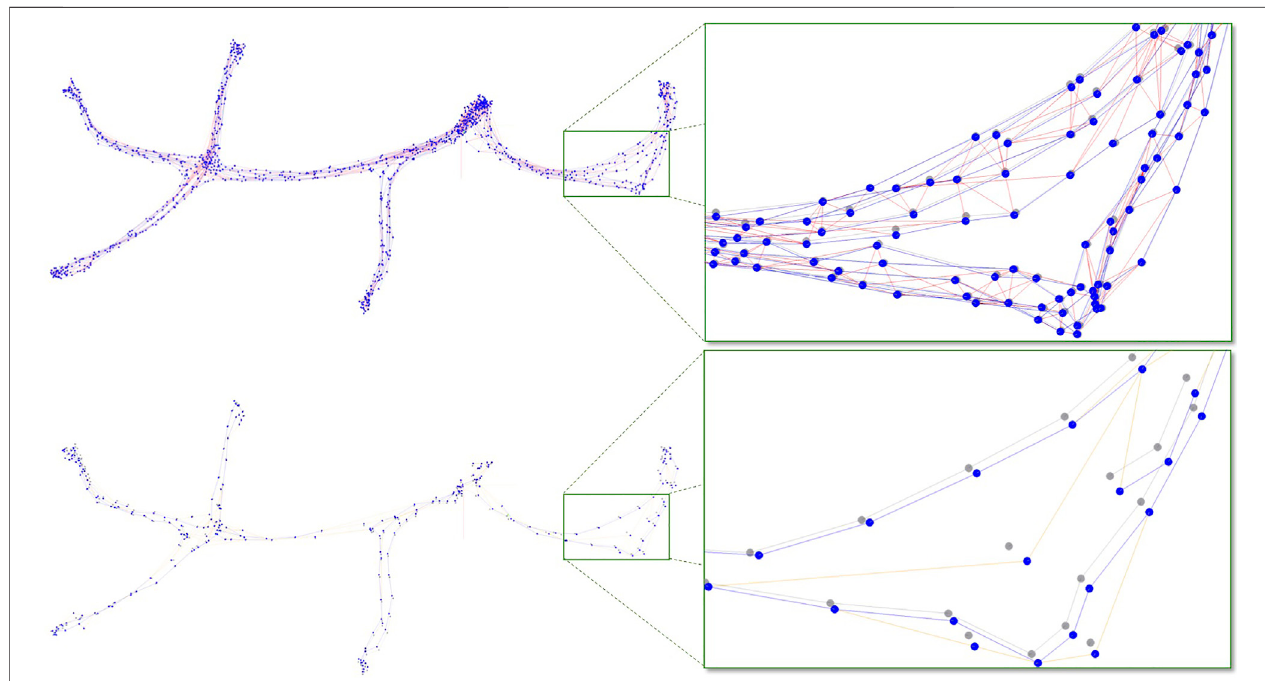
FIGURE 6 | Comparison ofthe multi-session maps 1+2+3+4+5+6 (top) and 1-2-3-4-5-6 (down) with SuperPoint feature. On the right are the zoomed parts of the corresponding rectangles on the left. Gray nodes correspond to what is considered to be the ground truth. Loop closure and odometry links are shown in blue and red, respectively. Orange links are created when reducing the graph (loop closure links propagated to neighbor nodes when a node is removed).